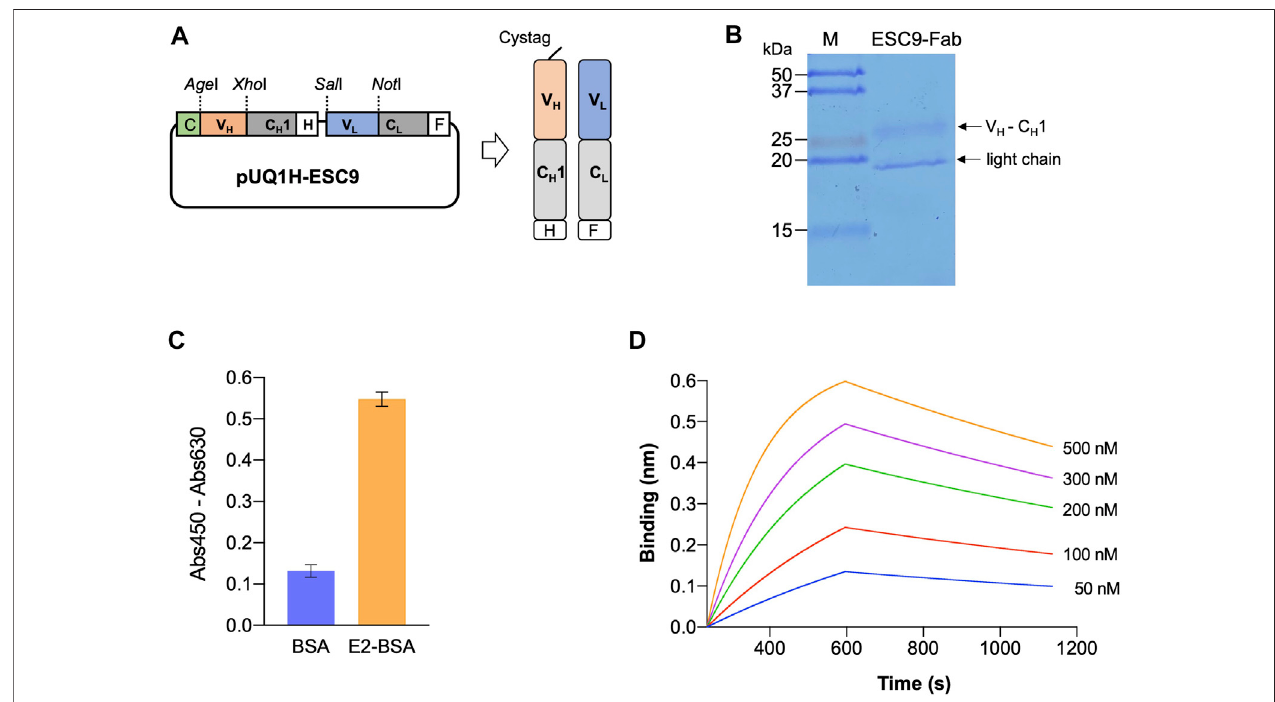
FIGURE 3 | Expression of antigen-binding fragment of ESC9 monoclonal antibody. (A) Construct of Fab expression vector; (B) SDS-PAGE analysis of puri fi ed ESC9 fragment; (C) ELISA of antigen-binding activity of puri fi ed Fab; (D) Sensorgram of bio-layer interference analysis ofESC9 Fab binding toE2. C: Cys-tag1; H: His 6 - tag; F: Flag-tag; C H 1: constant region 1 of human IgG1 heavy chain; C L : constant region of antibody light